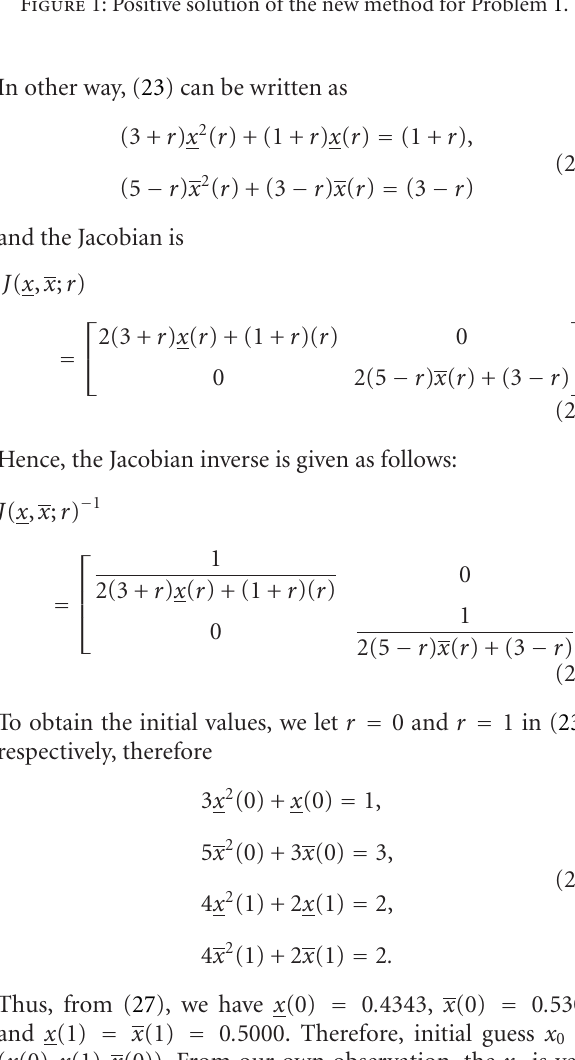
Figure 1: Positive solution of the new method for Problem 1.